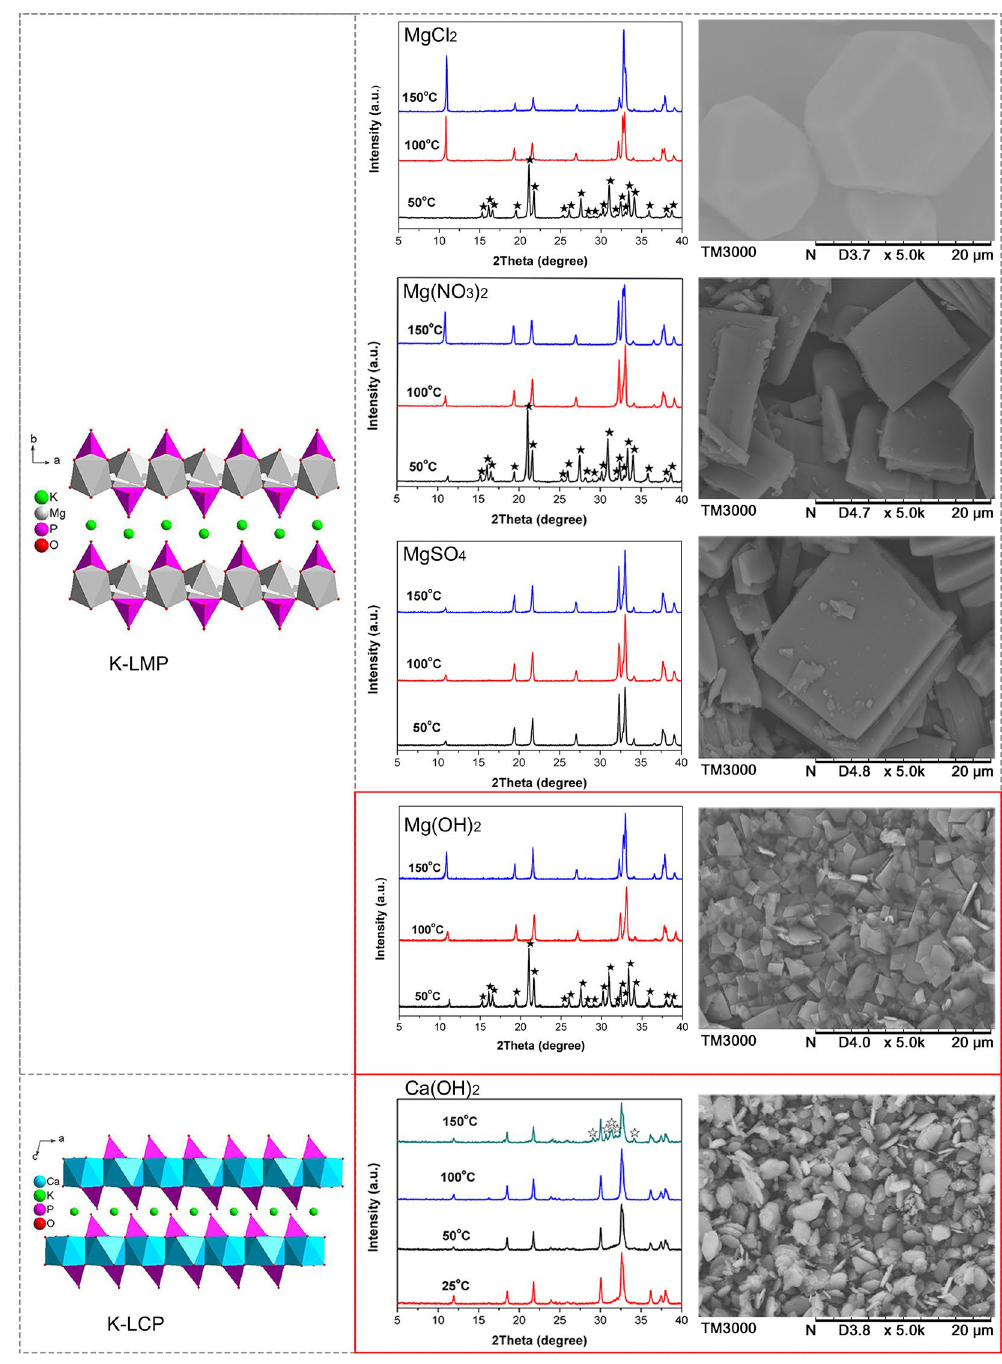
Figure 4. Controlling the particle size of layered magnesium and calcium phosphates. ( ★ = MgKPO 4 ∙6H 2 O; ☆ = impurity